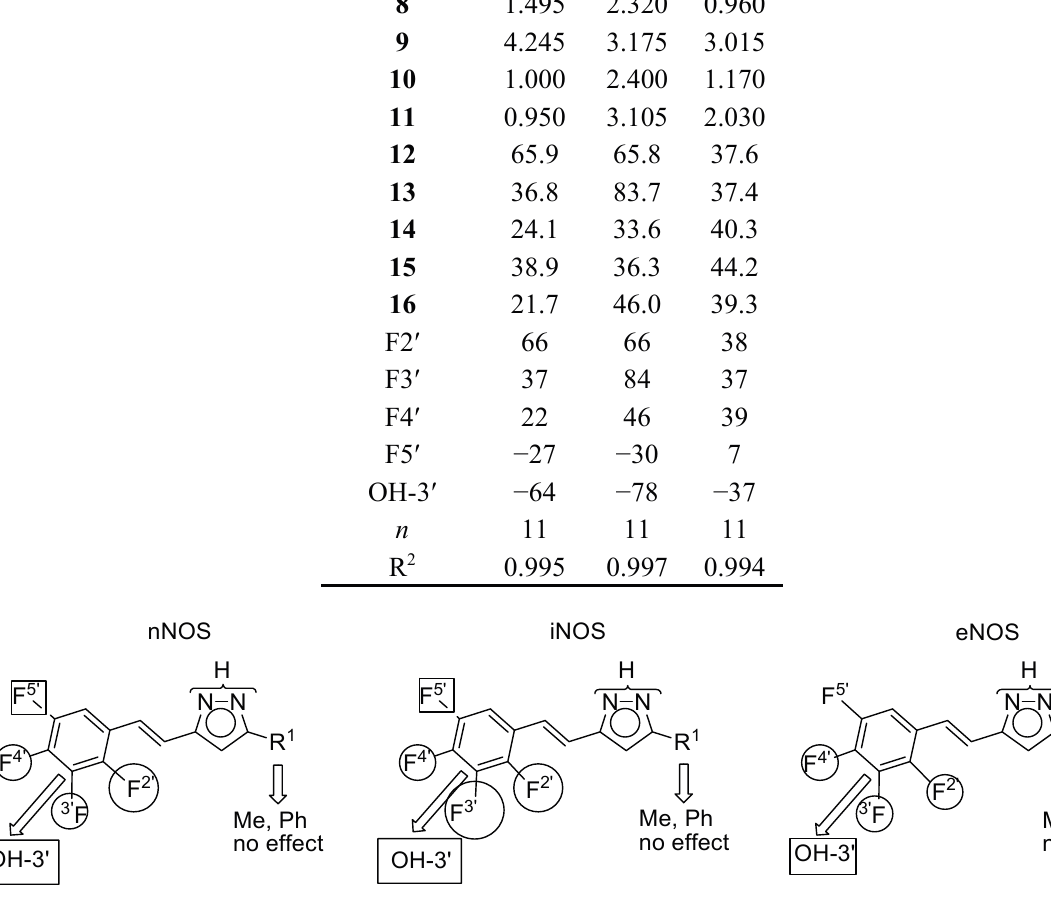
Figure 7. Circles, increase the activity; rectangles, decrease the activity. The size represents the importance of the